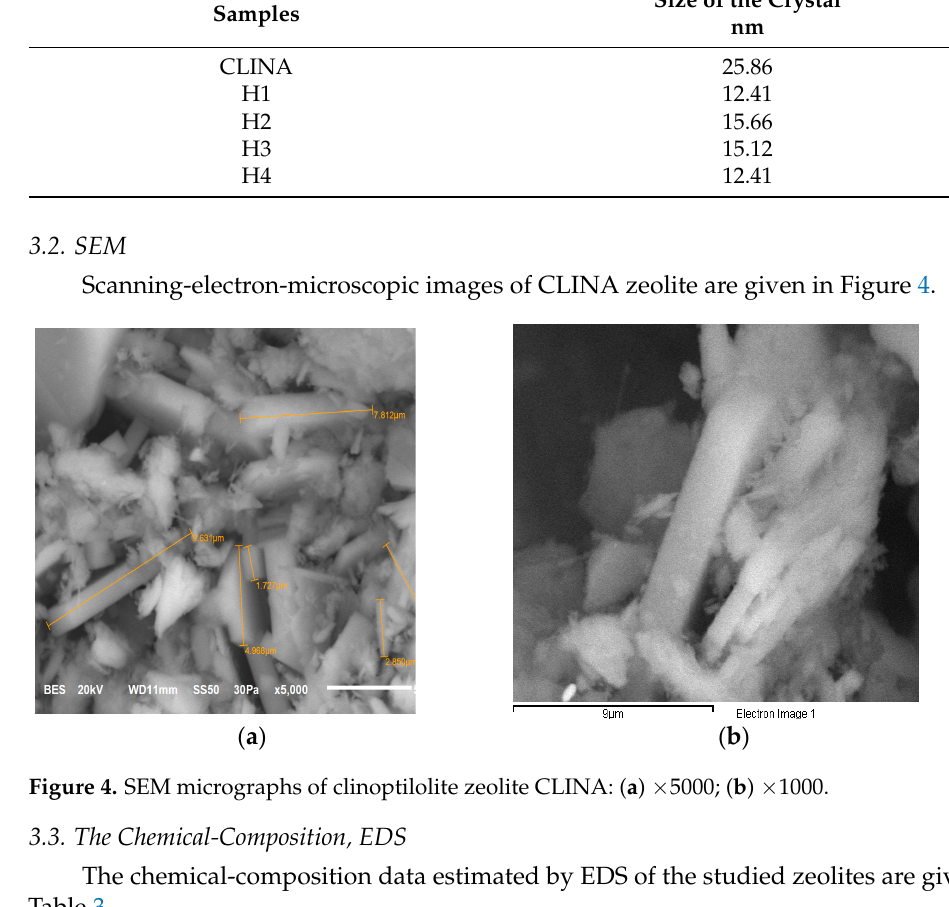
Table 3. Chemical compositions of clinoptilolite zeolites, EDS (%).